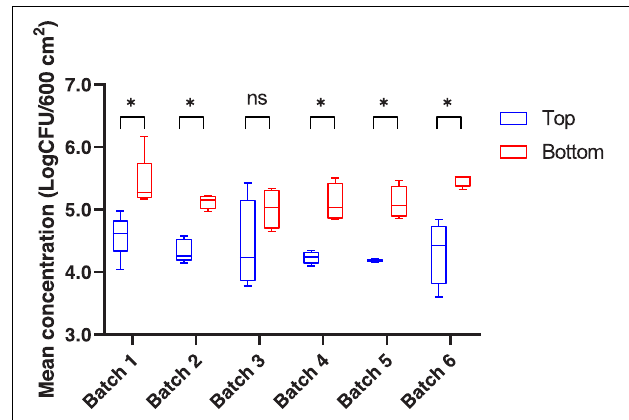
Values with different superscripts in a row are significantly different (p < 0.05). For Pseudomonas and Salmonella, the mean bacterial concentrations (log10 CFU/600 cm 2 ) were below the detection threshold for the method used. σ , standard deviation. A sample is considered positive if a bacterial count could been